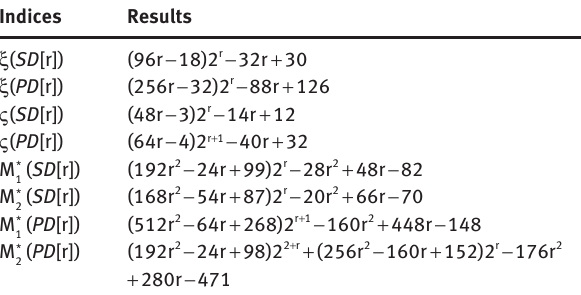
Table 5: Concluded